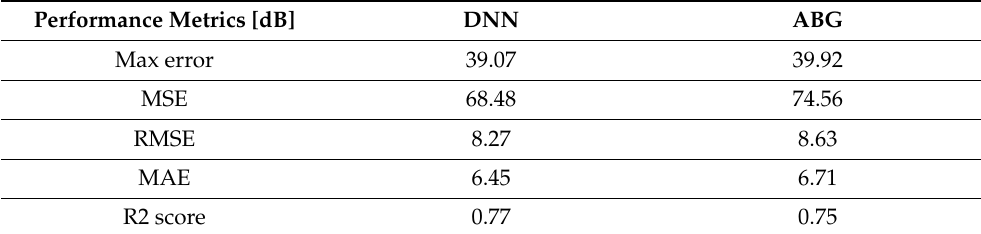
Table 4. Performance metrics of DNN and ABG path loss model.